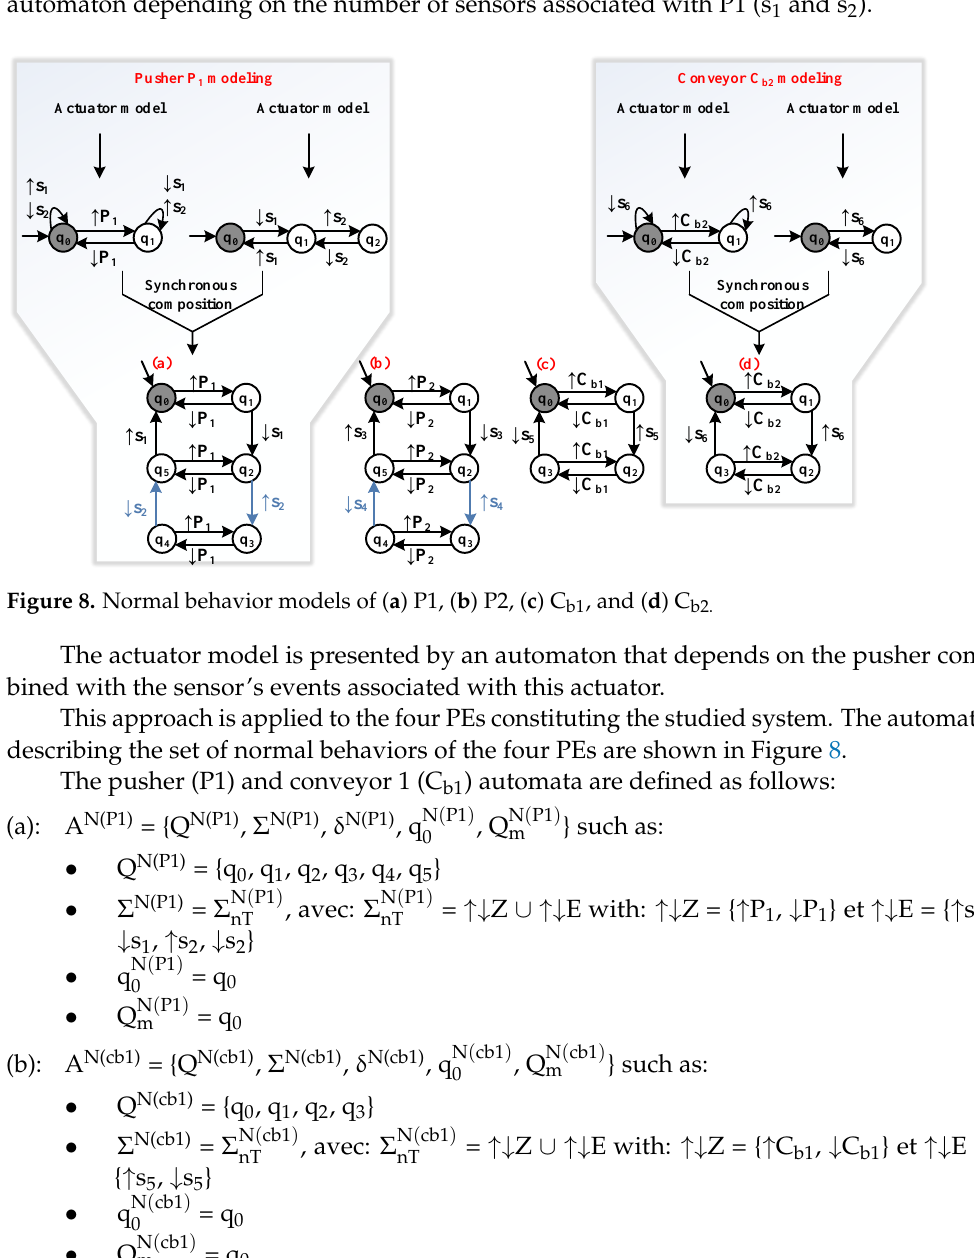
Figure 7. ( a ) boxes transfer system, ( b ) the system’s actuators and sensors.